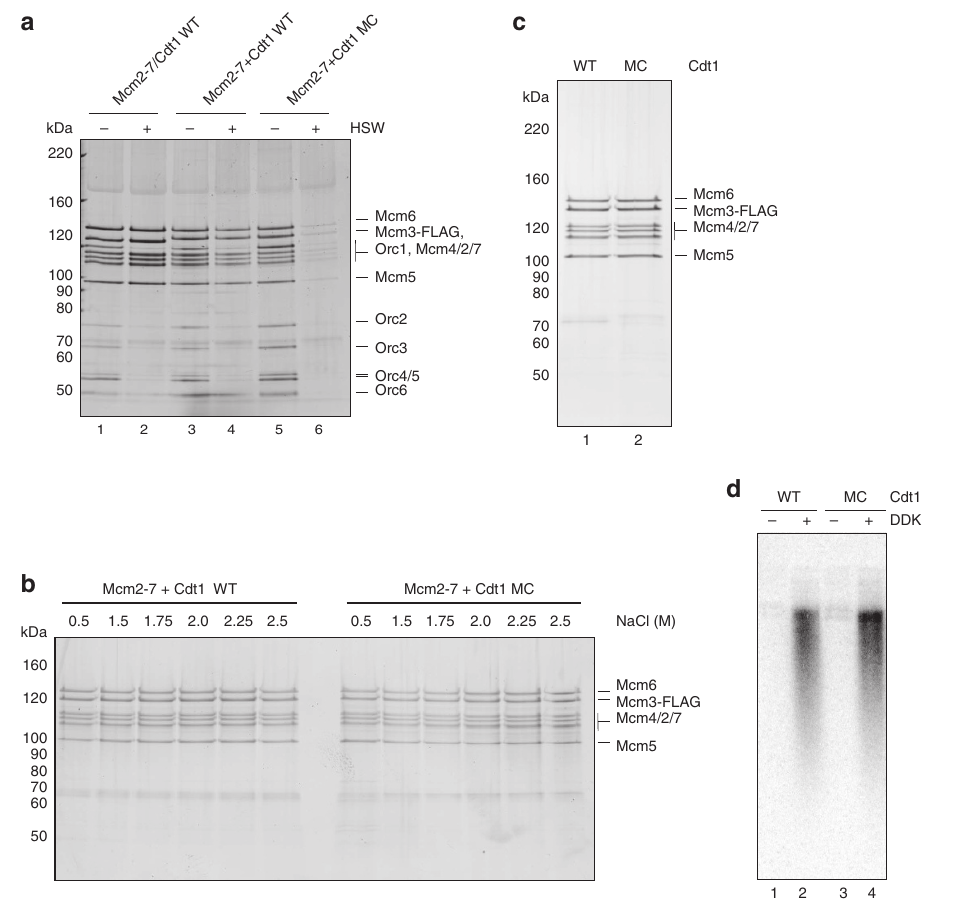
Figure 3 | The N domain is important for MCM loading. ( a ) Mcm2–7 recruitment ( (cid:2) high-salt wash, HSW) and loading ( þ HSW) on DNA analysed by SDS–PAGE and silver staining. Loading of co-expressed Cdt1–MCM complexes (lane 2) is more efficient than loading with reconstituted complexes of Mcm2–7 and Cdt1 WT (lane 4). Loading is dramatically reduced with Cdt1MC (lane 6). Recruitment of Mcm2–7 is not as dramatically affected (lanes 1, 3, 5). ( b ) Mcm2–7 loading on DNA analysed by SDS–PAGE and silver staining. Loaded Mcm2–7 is stable in high-salt washes up to 2.5M NaCl, both when loaded with Cdt1 WTor Cdt1MC. ( c ) Mcm2–7 loading on DNA analysed by SDS–PAGE and silver staining (left), and ( d ) alkaline agarose gel (right) of replication products after in vitro replication assays using S-phase whole-cell extract. When adjusting levels of Mcm2–7 loading (left) for Cdt1 WT (lane 1) and Cdt1MC (lane 2)-loaded hexamers, DDK-dependent replication products and efficiency is comparable